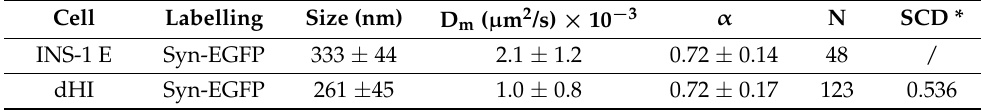
Table 1. i MSD-extracted parameters of syncollin-EGFP transfected dispersed HI and INS-1E.